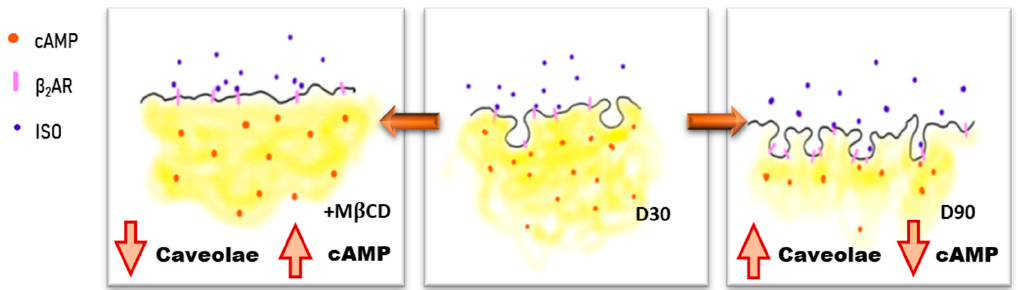
Figure 6. Schematic illustrating the changes in β 2 AR regulation, cAMP level, and caveolae upon the removal of cholesterol and upon the maturation of iPSC-CMs from D30 to D90.